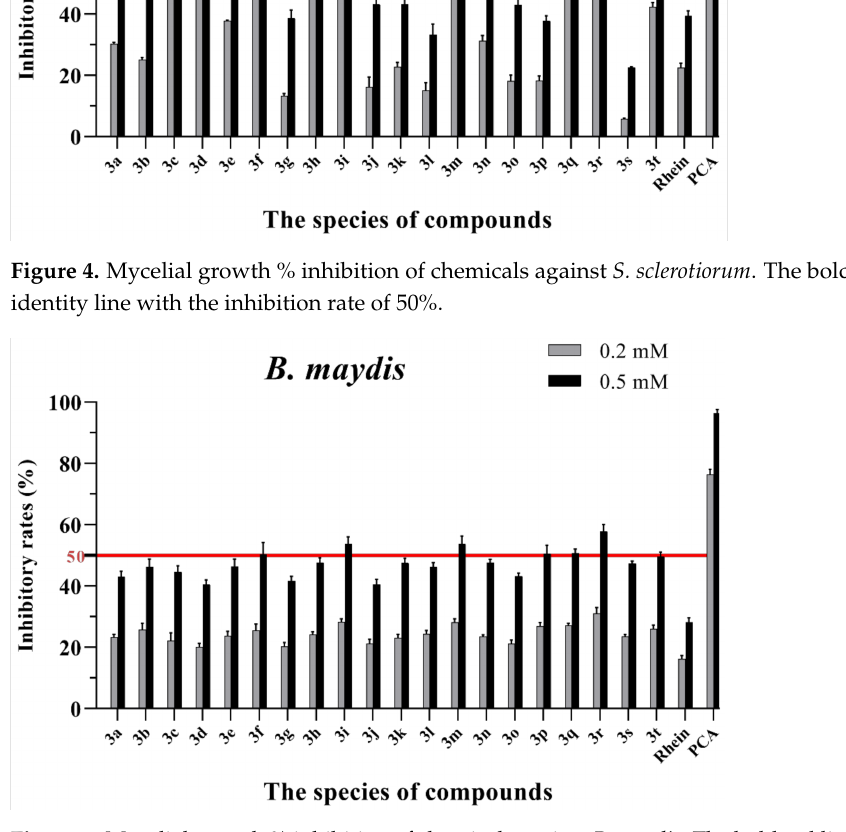
Figure 5. Mycelial growth % inhibition of chemicals against B. maydis . The bold red line is the identity line with the inhibition rate of 50%.